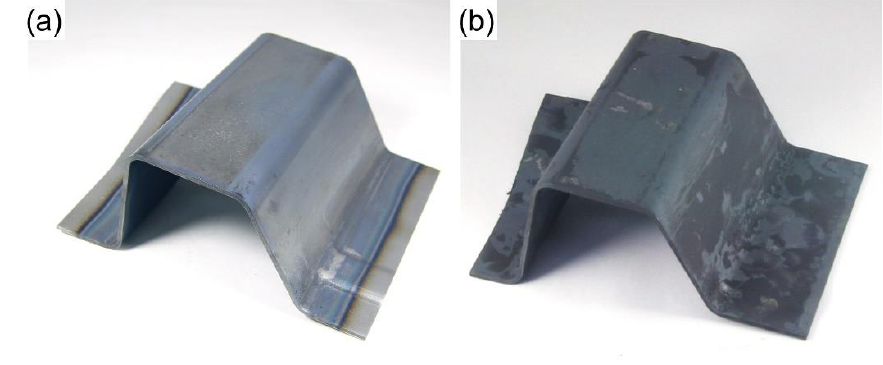
Figure 6. Hot hat-shaped bent parts using ( a ) direct resistance heating and ( b ) furnace heating.